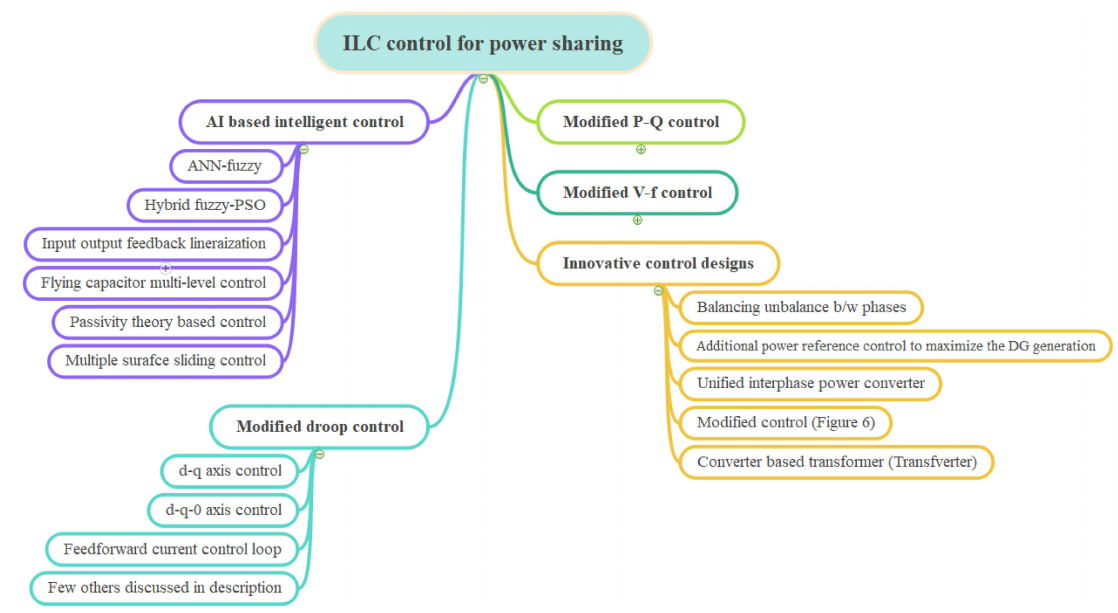
Figure 8. ILC control techniques for power